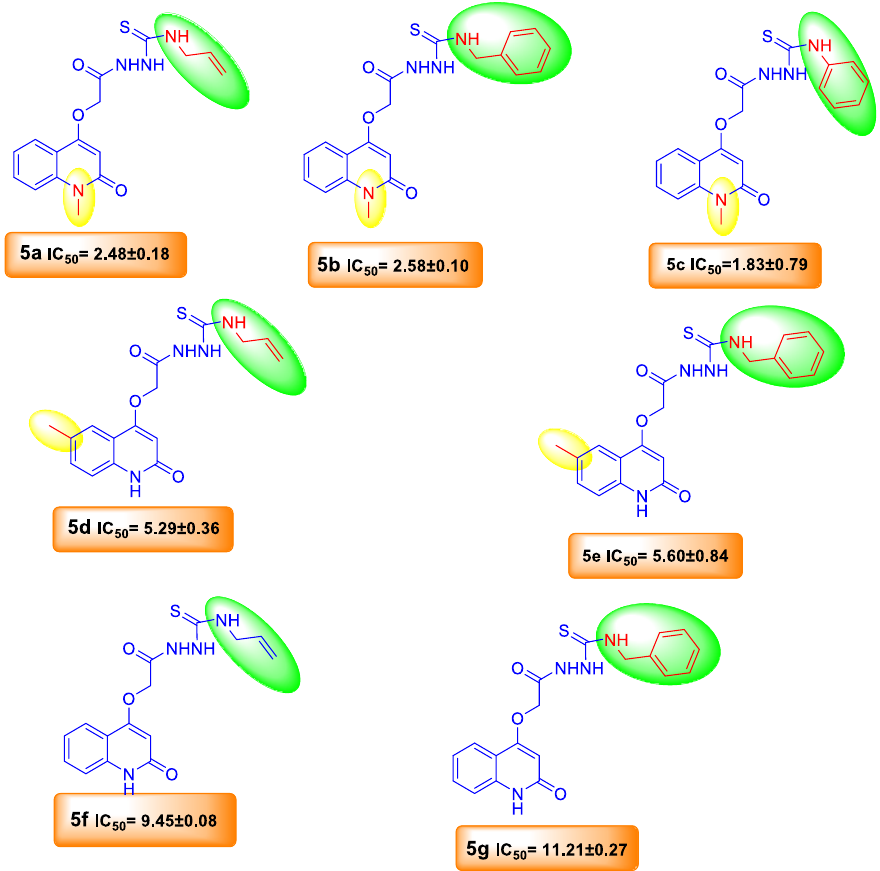
Figure 3. Comparison of SAR of compounds 5a – g.